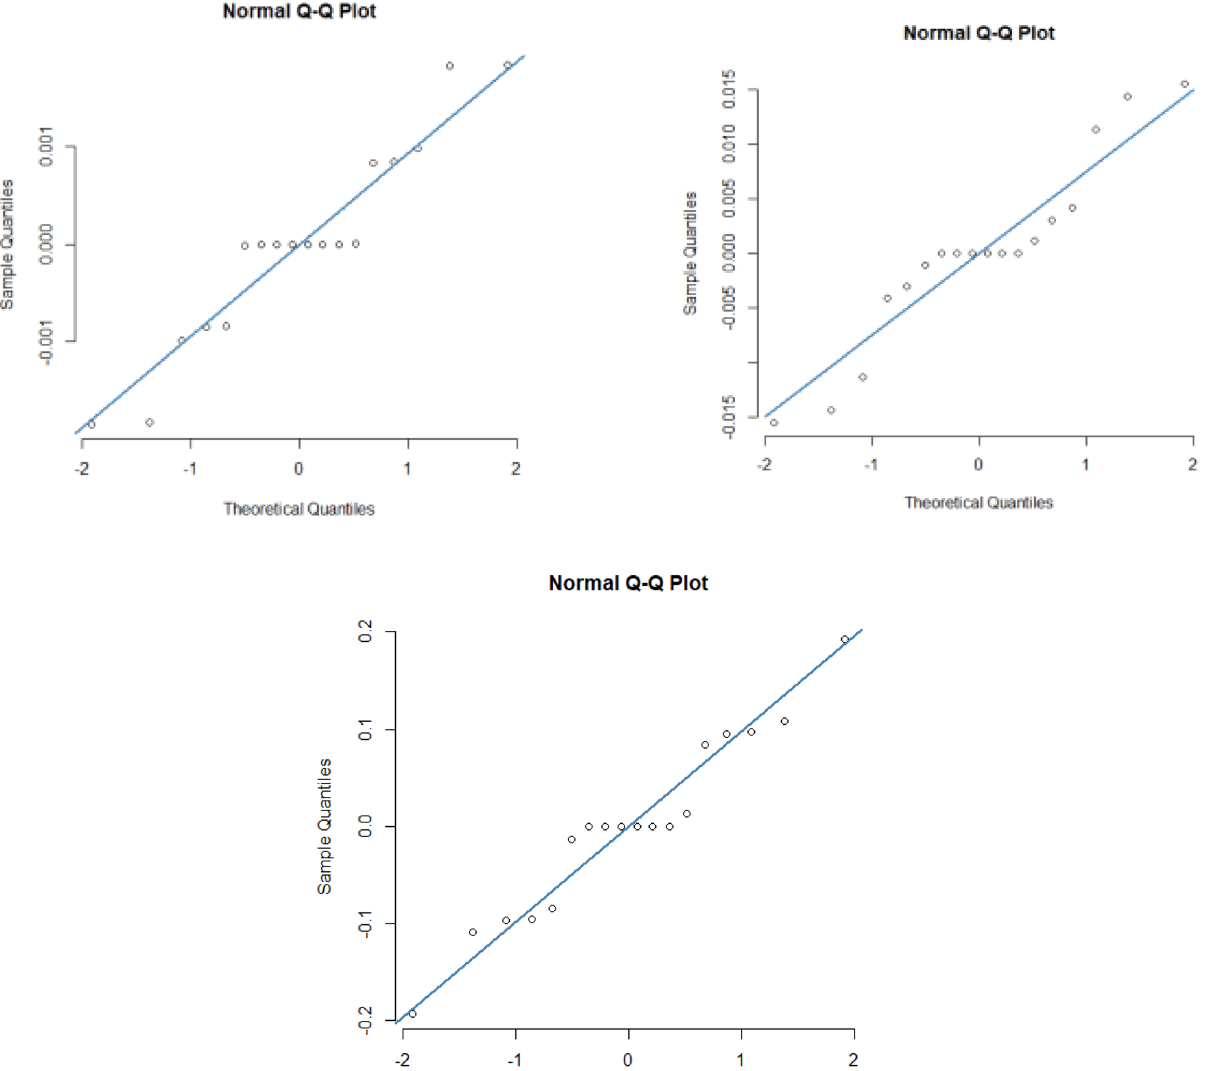
1 / 2 r is presented in the upper left panel, for 1 / 2 r is presented in the lower